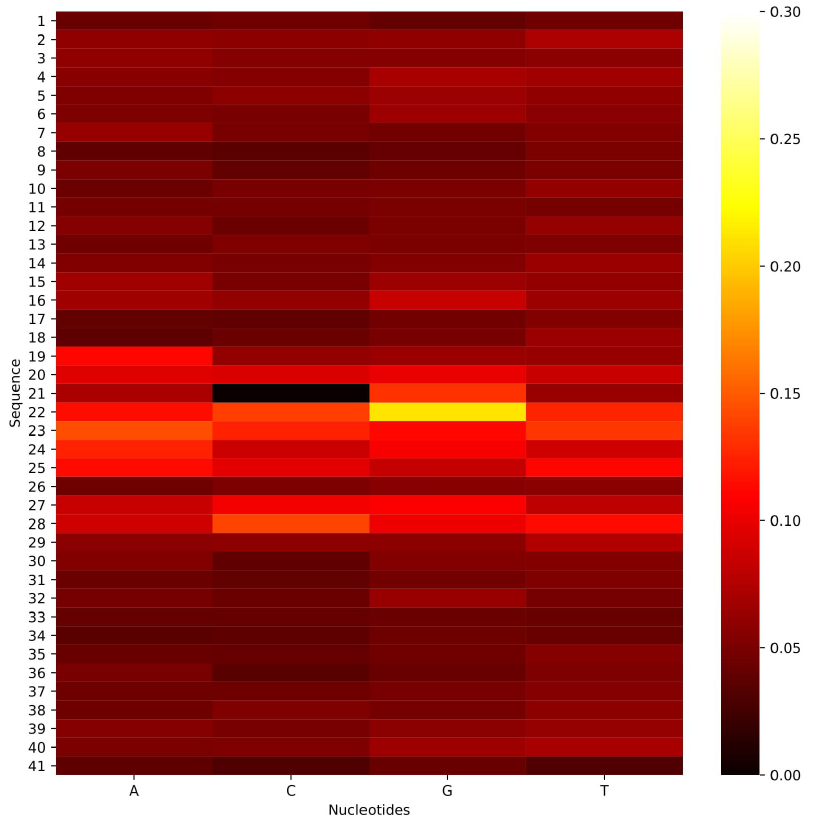
Figure 5. Demonstration of a heatmap visualization of in silico mutation of G. subterraneus .